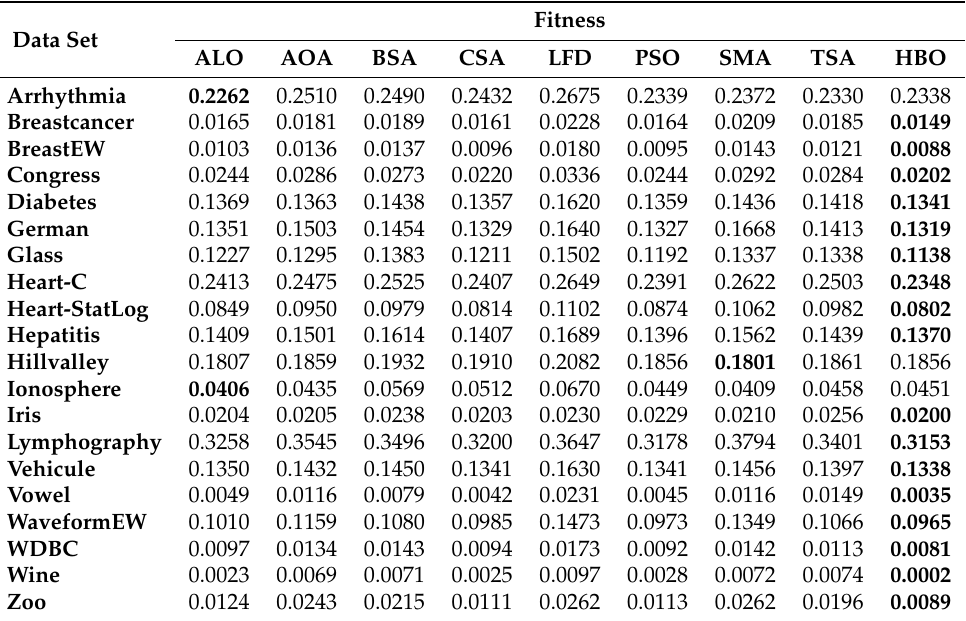
Table 4. The average fitness values of B_HBO against other recent